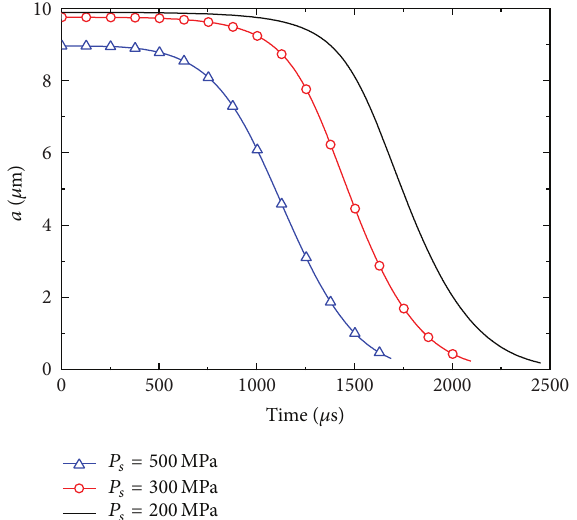
Figure 7: Time evolution of damage level under different pressures with the improved model.